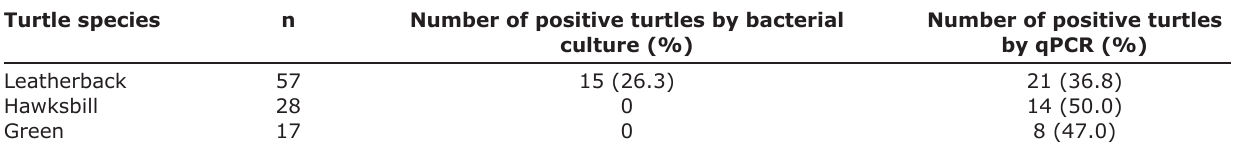
Table-1: Prevalence of Salmonella enterica in the cloaca of leatherback, hawksbill, and green turtles using bacterial culture and qPCR. Turtle species